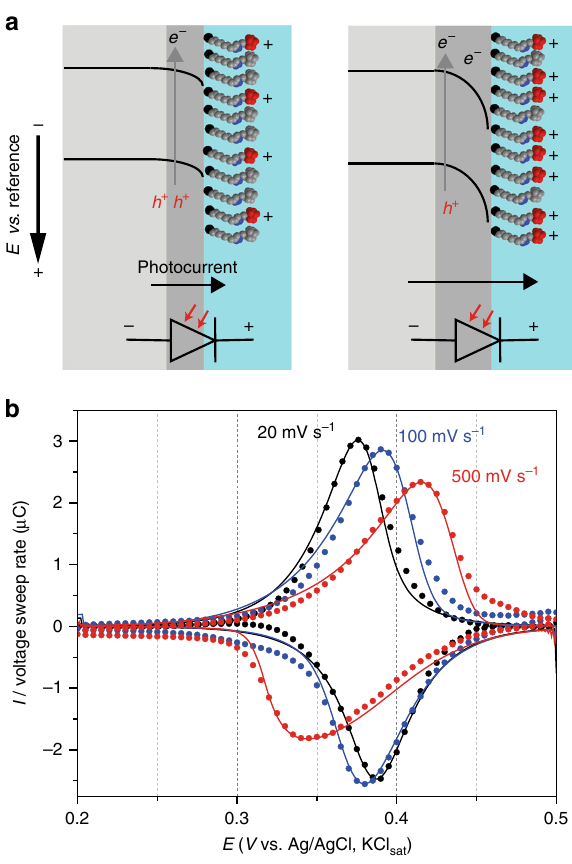
Fig. 5 Validation of the model and its implications for the correct kinetic analysis of charge-transfer reactions at semiconductors. a Energy-level diagram depicting the distortion of the semiconductor side of the barrier for a-Si photocathodes due to electrochemically induced changes to surface Fig. 6 Kinetic regions for the voltammetry as a function of the scan rate. charges. b Experimental (symbols) and simulated voltammograms (solid Evolution of the experimental peak potentials ( E peak , a ) and currents ( I peak , lines, model 3, Supplementary Note 6) for S-2 samples over a wide range of b ) as a function of voltage sweep rate ( ν ) in the cyclic voltammetry of S-2 voltage sweep rates (20 – 500 mV s − 1 ). Simulation parameters are listed in samples on a-Si. Black and white symbols correspond to the anodic and Table 1 cathodic data, respectively. Reversible (fast kinetics, R), and non-reversible ( fi nite kinetics, NR) zones are qualitatively indicated in fi gure. Lines are a guide to the eye only electrostatic effect (Fig. 5b, blue and red traces). In Fig. 6, we have tentatively marked two regions relative to the scan rate (R as short hand for reversible and NR for non-reversible, Supplementary Table 1 Interaction parameters obtained from current- Note 7) and it is clear that the reverse peak suffers the strongest potential curves in Fig. 5b in fl uences of both diode and kinetics. In the a-Si system the photodiode element is expected to point towards the electrolyte Direct scan Scan rate and the photocurrent is cathodic (Fig. 5a; Supplementary Fig. 20). (mV s – 1 ) Model 3 combines the effects of diode (through photocurrent and reverse saturation current) plus fi nite kinetics for the charge- transfer reaction at the monolayer side (through the correspond- ing rate constant and charge-transfer coef fi cient in the B – V formalism), and presence of interactions (through the Frumkin interaction parameters). The model appears therefore to be rather complex, but nonetheless the manifestation of the electrostatic calculated as a or = ( y – G )/2, a r = ( s + y )/2, a o = − ( s – y )/2 effect remains simple to diagnose in terms of narrow and inverted waves. The parameters used to re fi ne theoretical curves (Fig. 5b, segment ( I L (reverse scan) = 10 × I L (direct scan)), hence the solid lines) against experimental data (symbols) are given in inversion of the current peak on the potential. An increase in the Table 1. From the data in table it can be concluded that for small – 1 voltage sweep rate, ν , leads to a decrease of the effective rate ), there is no signi fi cant potential sweep rates (e.g., 20 mV s constant ( k et ν – 1 ) and therefore to an enhancement of the perturbation caused by the redox kinetics on the electrostatic of in fl uence of kinetics on the response, causing a shift of the the system. As a consequence of the electrostatics experienced by direct/reverse curves towards more positive/negative potentials, the space-charge of the electrode the photocurrent value for the respectively, which in turn masks the potential inversion. reverse scan is one order of magnitude greater that in forward NATURE COMMUNICATIONS | 8: 2066 | DOI: 10.1038/s41467-017-02091-1 |